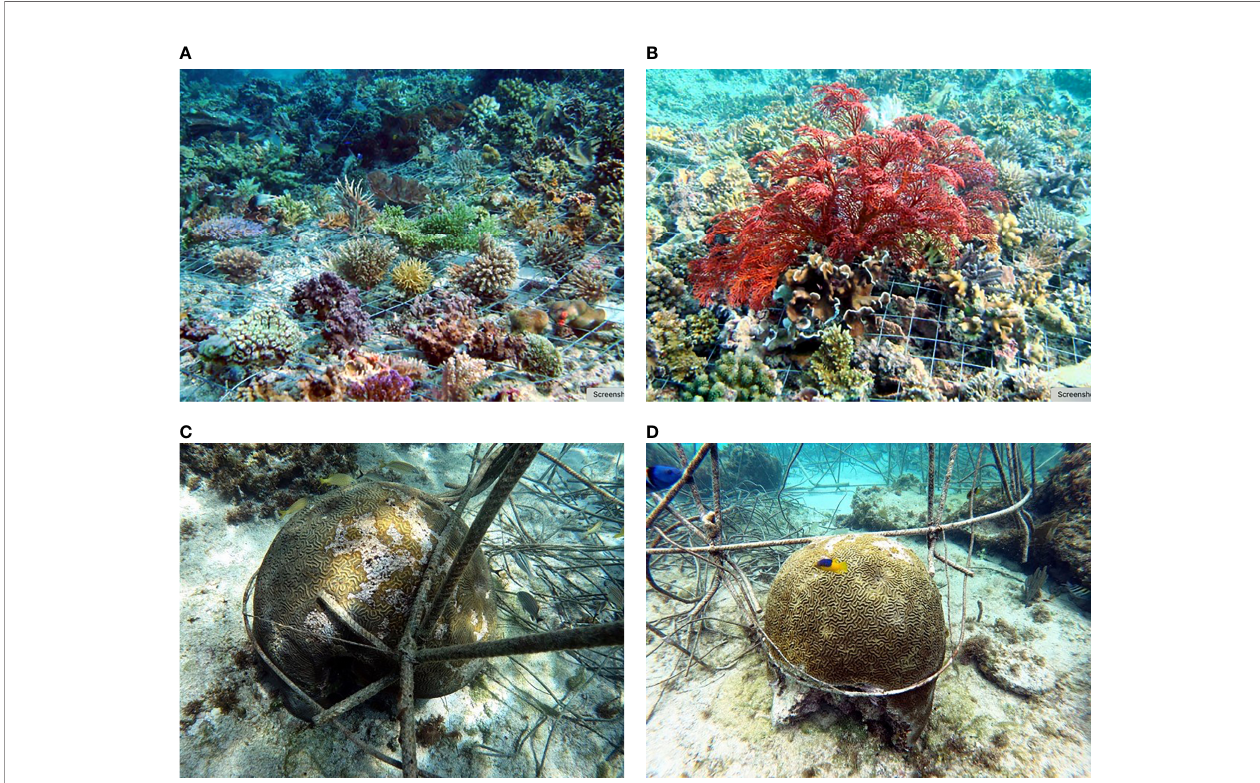
FIGURE 4 | (A) Loose broken hard and soft corals, with bright colors and with polyps fully expanded, after one night of electrical stimulation. Gili Trawangan, Lombok, Indonesia. (B) The red soft coral had been broken across the base by a storm and had been completely limp when placed on the mesh. The next morning it had not only healed the broken stalk; it was fully expanded and feeding. Gili Trawangan, Lombok, Indonesia. (C) February 23 2021, after three months in the electrical fi eld, the damaged areas have healed and are growing back as with dark rims of proliferating new tissue growing over the dead coral skeleton. Before being placed in the electrical fi eld, the tissue next to them had been necrotic and dying back. (D) After eight months, on June 4 2021 this old coral was nearly completely healed from severe injuries. It had not been expected to survive before it was placed in the electrical fi eld. Negril, Jamaica, photographs by Sharren